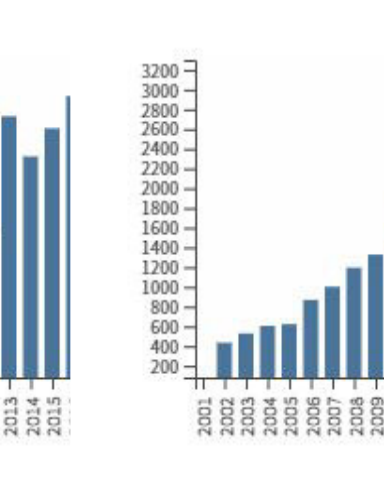
Figure 1 . Total publications by years Figure 2. Number of citations by